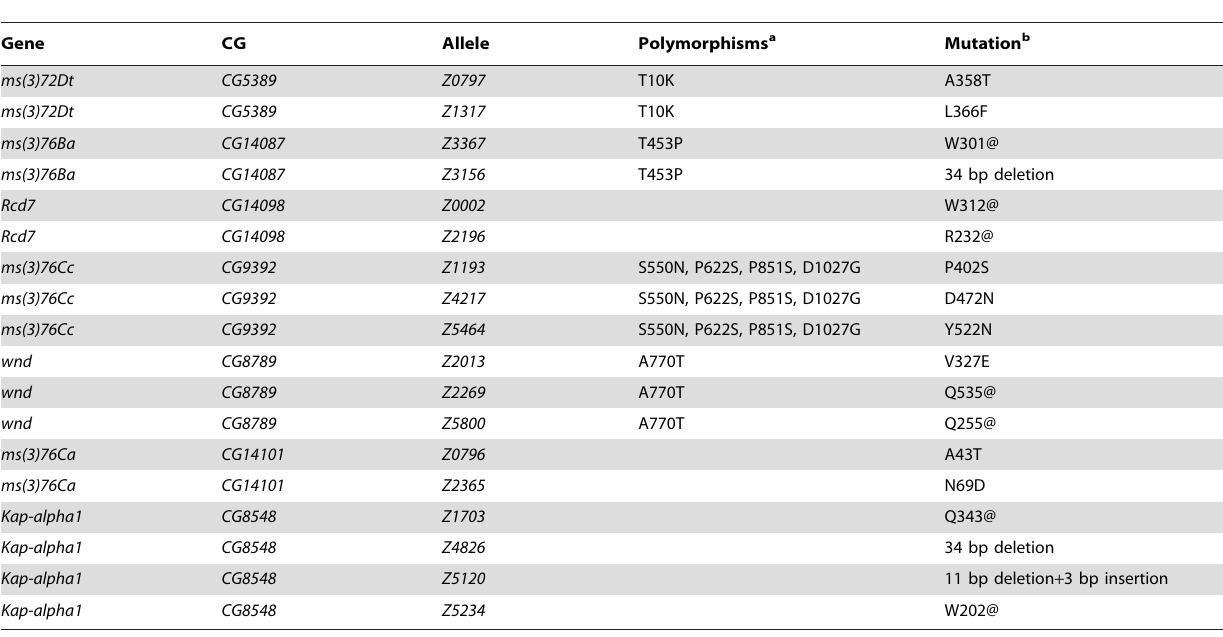
Table 5. Amino-acid polymorphisms and mutations associated with male-sterile mutations from the Zuker collection.